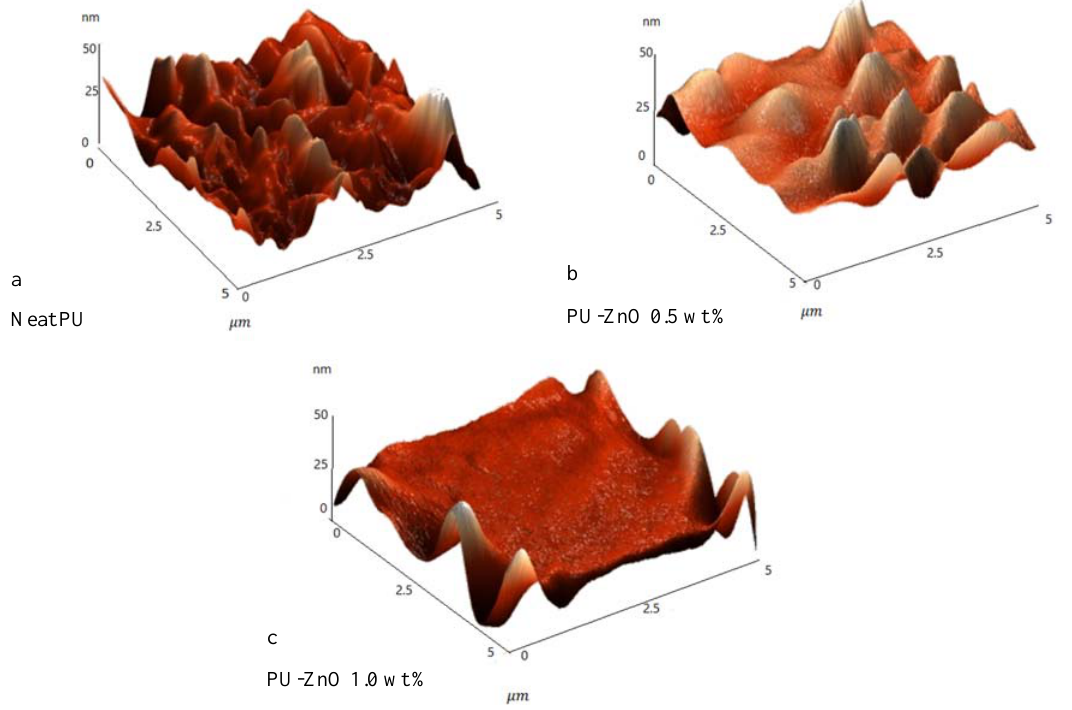
Figure 3. AFM images of the MMMs ( a ) neat PU; ( b ) PU ‐ ZnO 0.5 wt %; ( c ) PU ‐ ZnO 1.0 wt %.